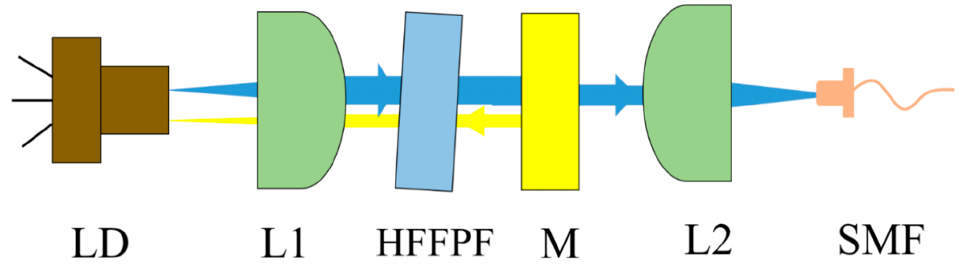
Figure 2. Setup of the self-injection-locked laser using the HFFPF. LD: laser diode; L: aspherical lens; HFFPF: High finesses Fabry–P é rot filter; M: 90 %-transmissivity partial-reflection mirror; SMF: single mode fi ber.